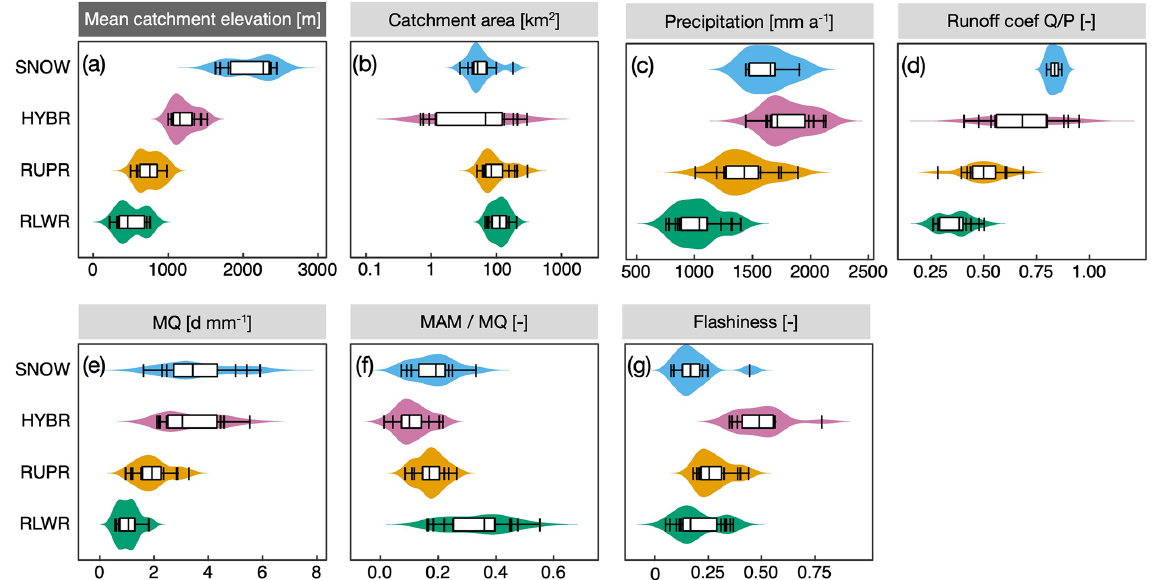
Figure A1. Distribution of catchment, climate and streamflow characteristics across the four catchment groups. Data points outside the boxplot range are marked with vertical lines. Catchment characteristics (a, b) are derived from the Federal Office for the Environment (FOEN, 2013); catchment precipitation (c) is estimated on basis of gridded daily precipitation P (MeteoSwiss RhiresD; 2km interpolated observation data set). For streamflow related metrics (d–g) the same streamflow data are used as described in Sect. 3. Streamflow metrics show the distribution of average daily flow (e) , ratio of mean annual minimum flow to average flow as metric for low-flow stability (f) and the R–B Index (Baker et al., 2004), where higher values indicate higher hydrograph flashiness (g)